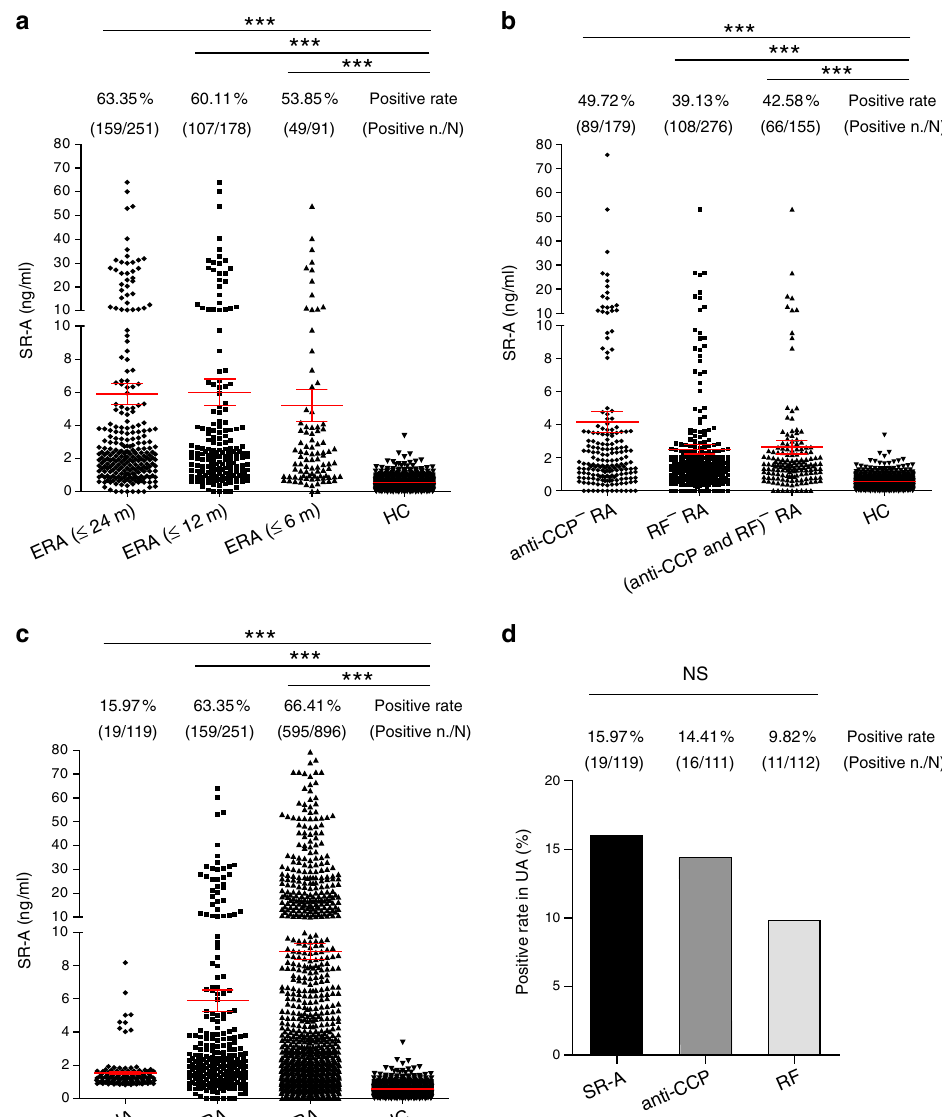
Fig. 5 sSR-A in ERA, anti-CCP and/or RF-negative RA and UA patients. a The levels of sSR-A in early RA (ERA) patients, including patients with disease duration <24 months ( n = 251, *** p < 1E − 15), <12 months ( n = 178, *** p < 1E − 15), and <6 months ( n = 91, *** p < 1E − 15) were detected. The positive rates of sSR-A were also analyzed. b The levels of sSR-A as well as the positive rates in anti-CCP and/or RF-negative RA patients, including anti-CCP - RA patients ( n = 179, *** p < 1E − 15), RF - RA patients ( n = 276, *** p < 1E − 15), and (anti-CCP and RF) - RA patients ( n = 155, *** p < 1E − 15) were examined. c Comparing sSR-A levels and positive rates in UA ( n = 119, *** p < 1E − 15), ERA ( n = 251, *** p < 1E − 15) and RA ( n = 896, *** p < 1E − 15) patients. d Prevalence of sSR-A, anti-CCP, and RF in undifferentiated arthritis (UA) patients. n : the number of sSR-A-positive patients; N : the number of total patients. Red horizontal lines: means; error bars: SEMs. *** p < 0.001, NS, not signi fi cant (Kruskal – Wallis test followed by Dunn ’ s posttest for multiple comparisons a – c or Chi-square test d ). Source data are provided as a Source Data fi